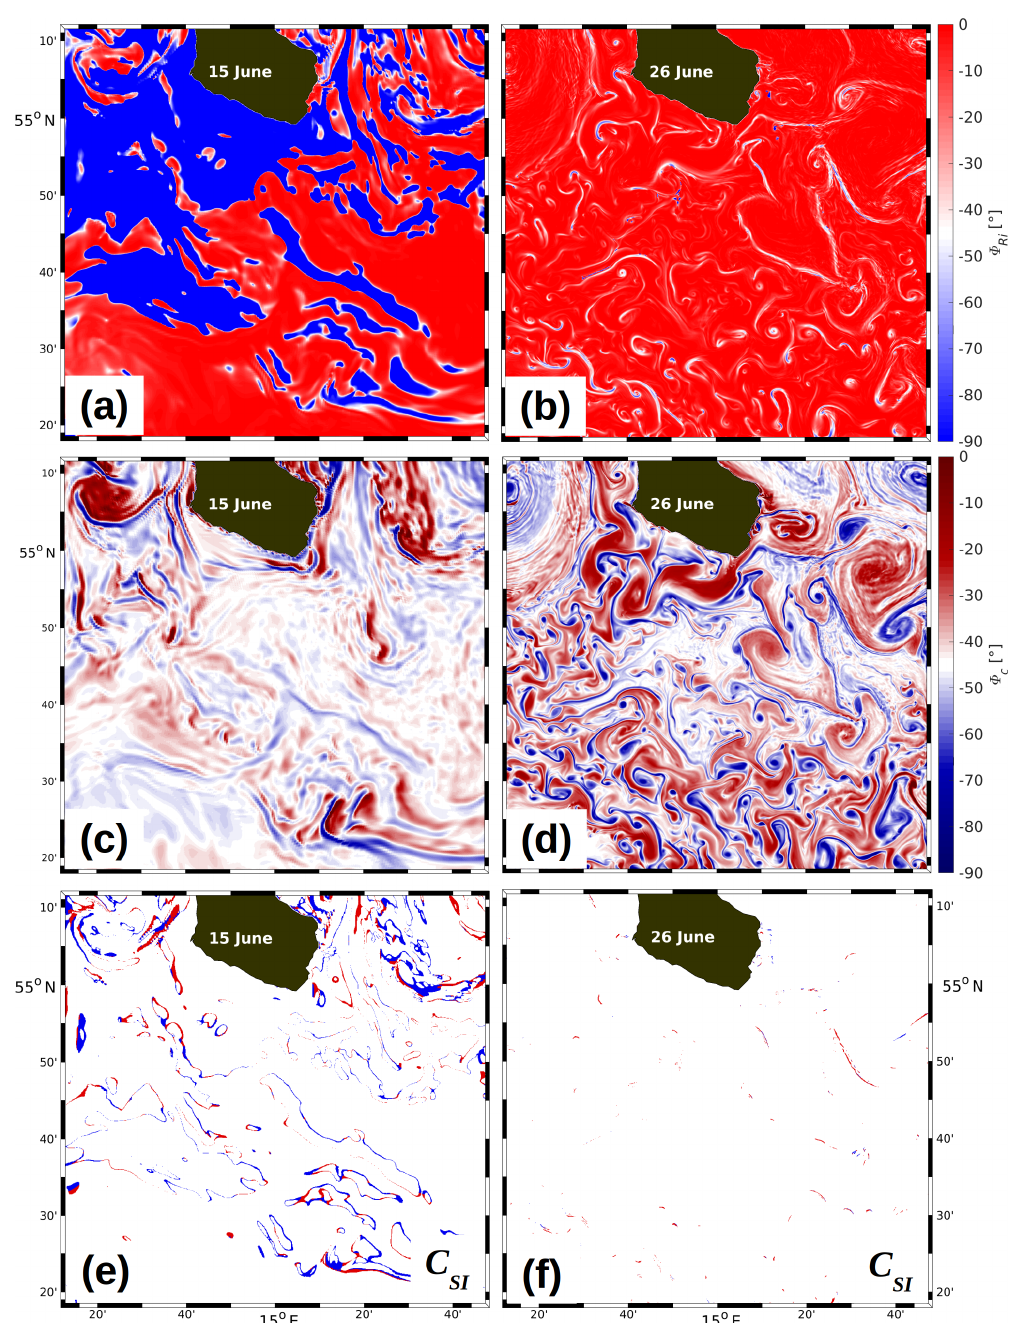
Figure 14. R100: (a, b) φ Ri , (c, d) φ c , and (e, f) C SI at 2m of depth on 15 (left) and 26 June (right). Panels (e) and (f) are logical maps indicating where the condition for symmetric instability, C SI , is satisfied in regions of cyclonic (red) and anticyclonic (blue) absolute vorticity according to Eqs. (17) and (18), respectively. For an explanation of the other symbols, see the text.